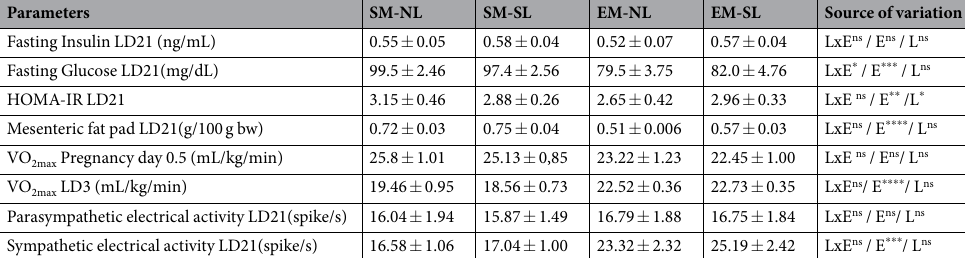
Table 1. Effect of low intensity physical exercise training on metabolism and fat pad stores in mothers. Data are expressed as the mean ± SEM. at LD21 (n = 10–12 per group). LxE, interaction between the exercise factor and the litter factor; E, exercise factor and L, litter factor; * p < 0.05, ** p < 0.01, *** p < 0.001, **** p < 0.0001 and ns, no significant difference, based on a two-way analysis of